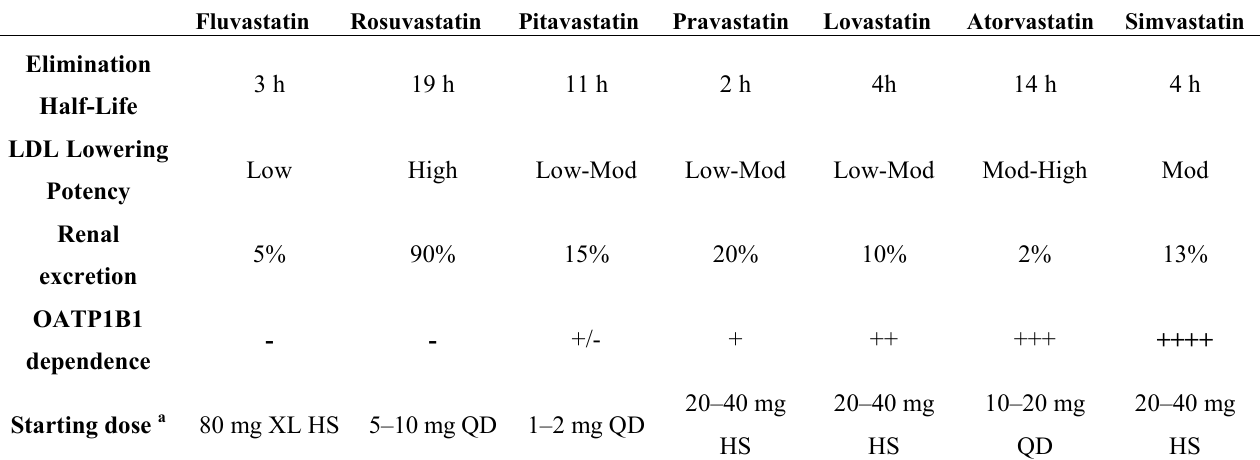
Table 4. Statin Pharmacologic